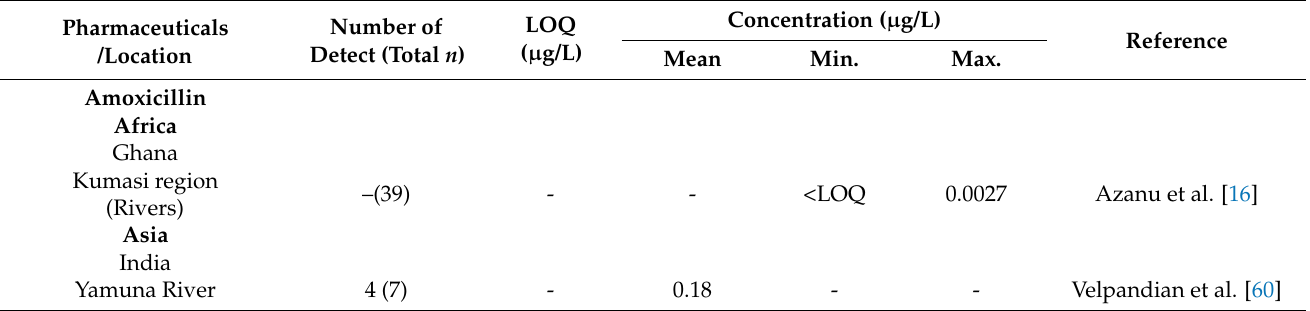
Table 2. Concentrations of amoxicillin, enrofloxacin, and neomycin reported in surface waters